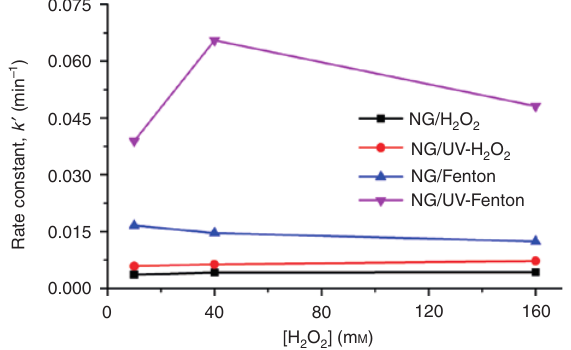
O concentration on NG decomposi- Figure 5: Influence of initial H 2 2 tion by different AOPs. Figure 6: Effects of pH on the degradation of (A) NG and (B)